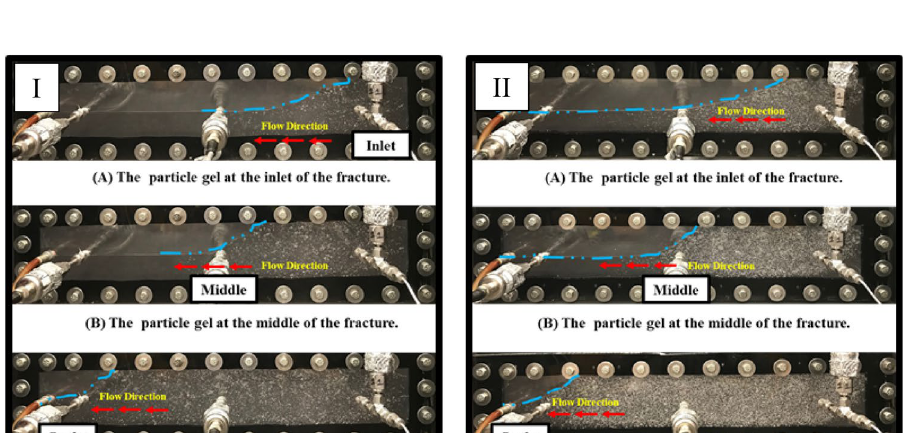
Fig. 5 a Gel propagation injec- tion pressure through fractures width of 0.5 mm using 1450 pa strength (gel size/fracture width ratio is 6.4) and b gel propaga- tion through fractures width of 0.5 mm using 550 pa strength (gel size/fracture width ratio is 9.76)